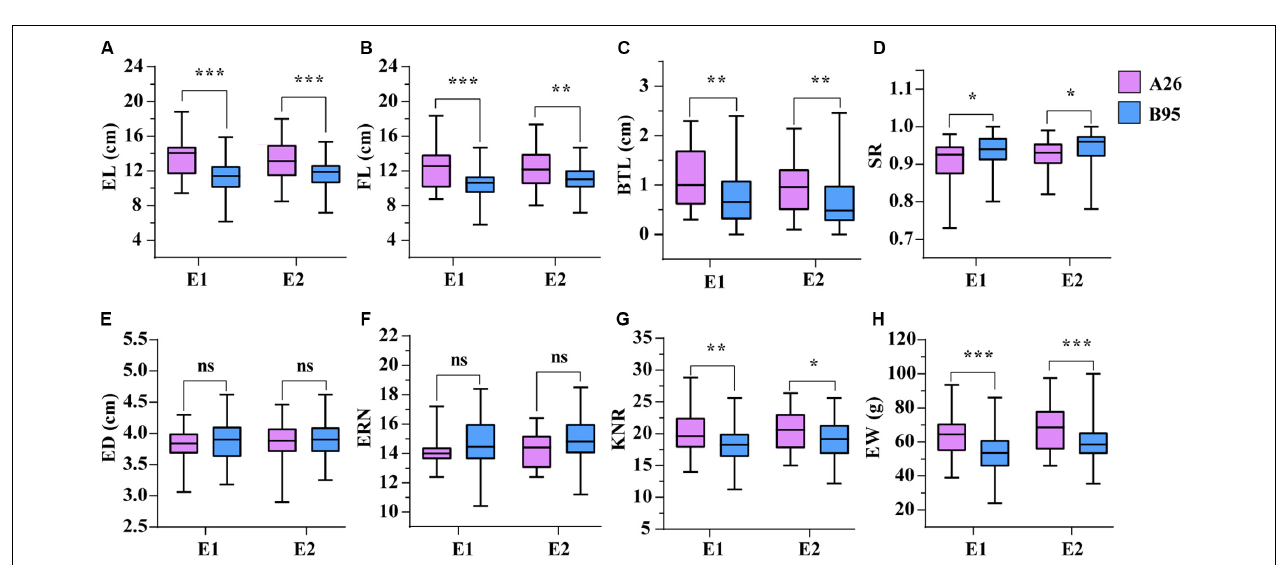
FIGURE 5 | The comparison of eight traits between A26 and B95 in two environments. (A) Ear length (EL, cm). (B) Fruit length (FL, cm). (C) Barren tip length (BTL, cm). (D) Setting rate (SR). (E) Ear diameter (ED, cm). (F) Ear row number (ERN). (G) Kernel number per row (KNR). (H) Ear weight (EW, g). *, **, and *** indicate significant level at P < 0.05, P < 0.01 and P < 0.001, respectively. ns represents no significant